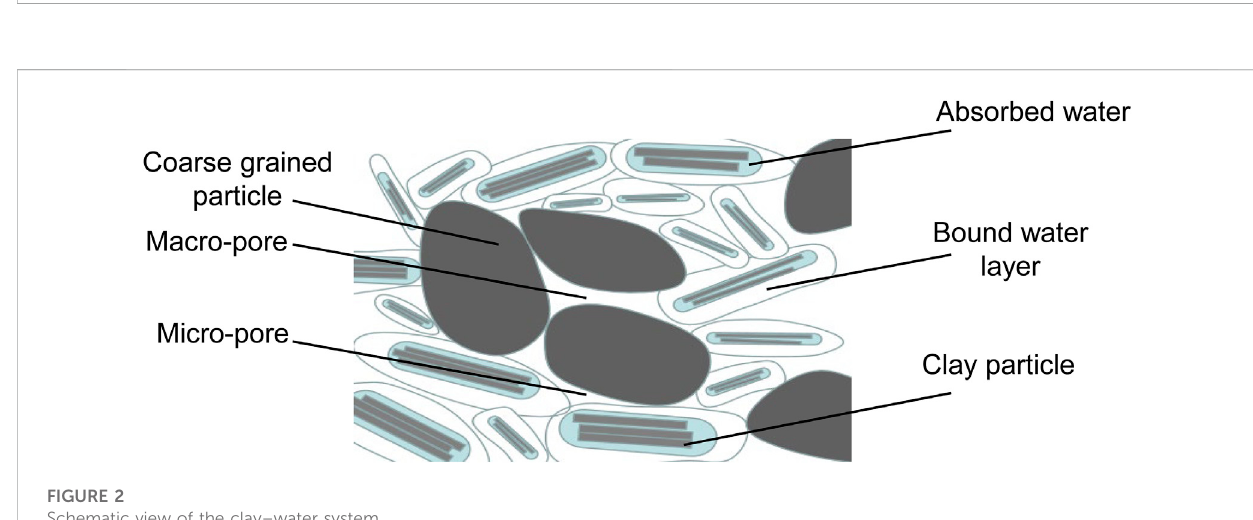
FIGURE 1 Schematic diagram of the double electric layer.